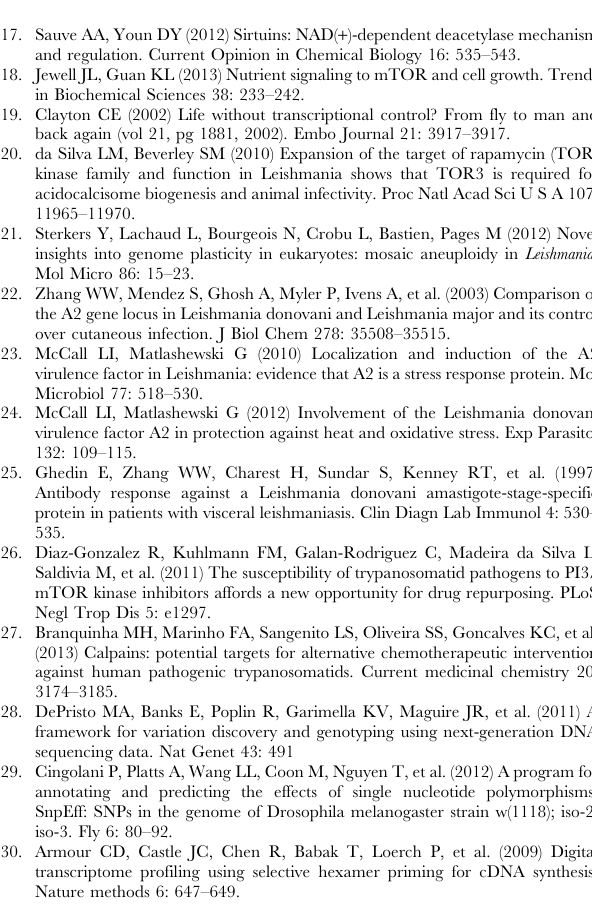
Table S1 Non-synonymous changes identified in the CL-SL isolate. Table S2 Genes with transcript levels more than 2 fold Up- regulated in VL-SL. Table S3 Genes with transcript levels more than 2 fold Up- regulated in CL-SL. Table S4 List of primers used for RT-PCR. Test S1 Supporting